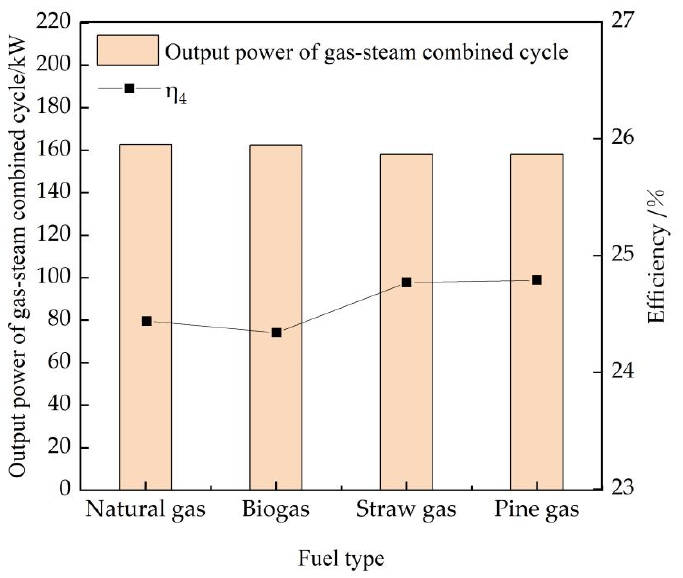
Figure 4. Efficiency diagram of micro gas-steam combined cycle system.